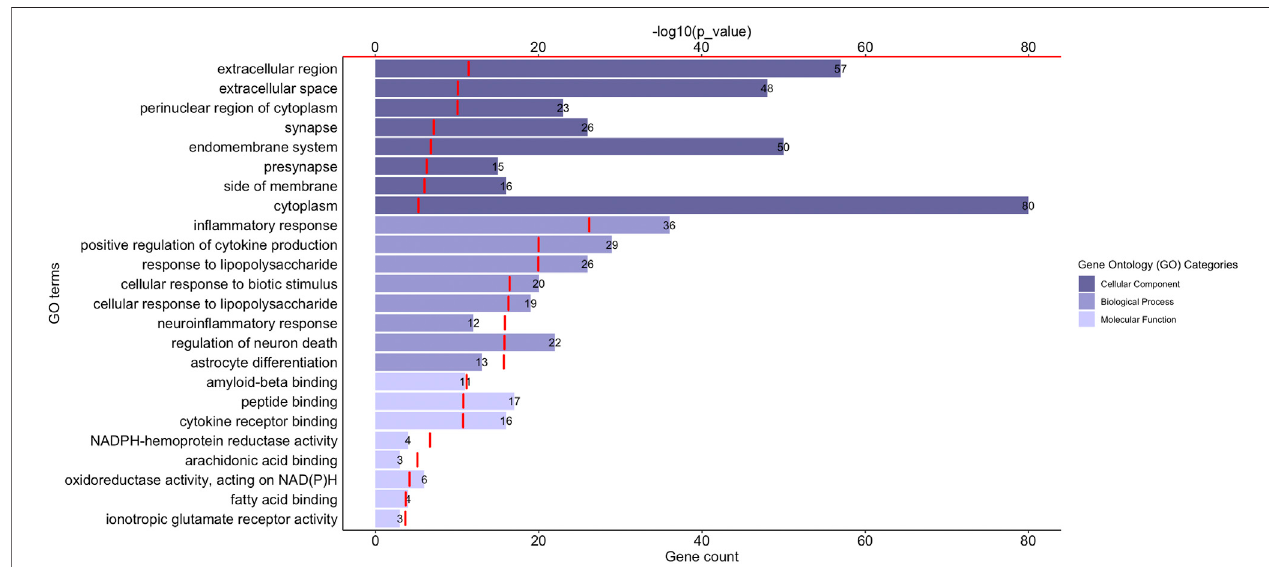
FIGURE 2 | Functional enrichment analysis of the proteins associated to neuroin fl ammation in Alzheimer ’ s disease. The graph shows the top eight over- represented Gene Ontology (GO) cellular localization, GO molecular functions and GO biological pathways annotations ( Y -axis), the number of proteins of our dataset includedineach term(lengthofthehistogrambarsandnumberdisplayed nexttoeachhistogrambar,lower X -axis)andthe − log10( p _value)levels(redsegments,upper X -axis). p -value ≤ 0.05.